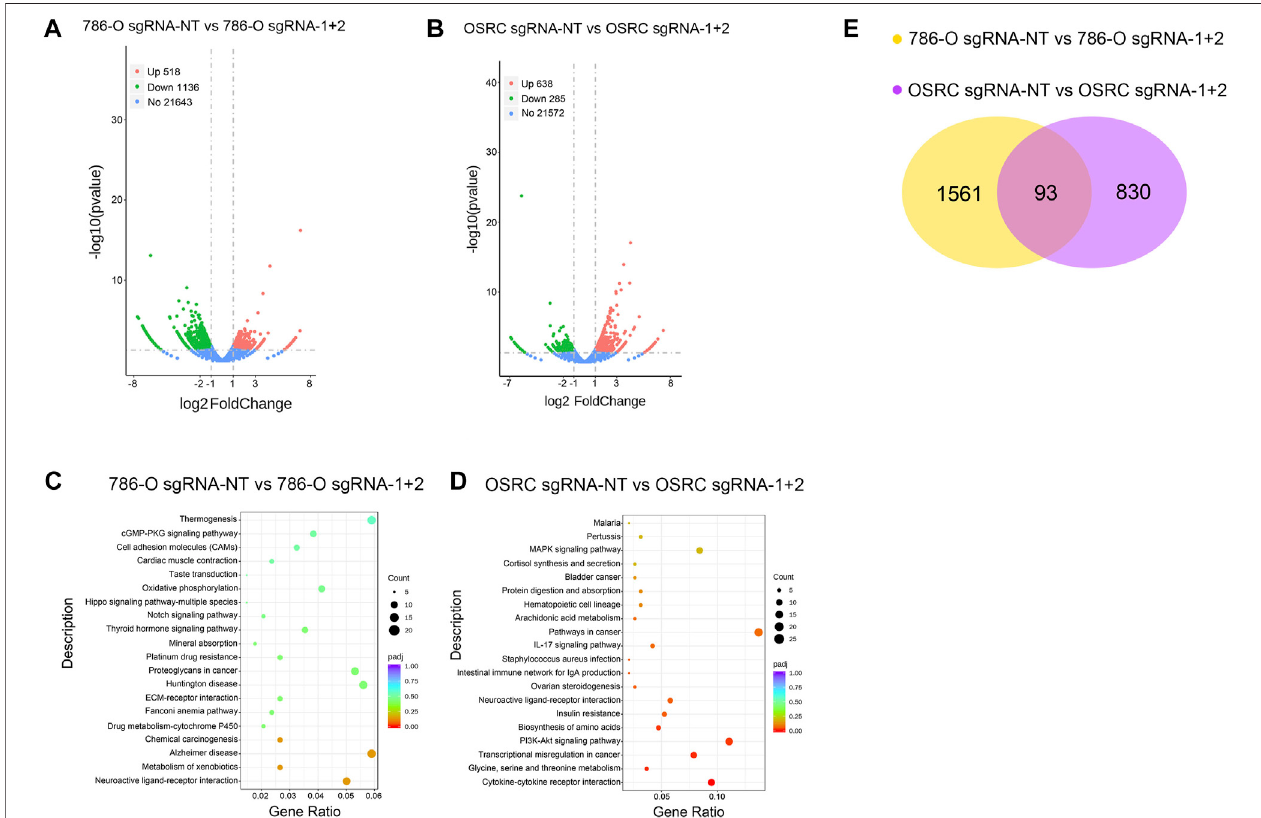
FIGURE 5 | The effect of LncRNA NEAT1 Hypermethylation on the transcriptome (A,B) Differentially expressed genes in 786-O and OSRC cells after transfected with dCas13 b-METTL3 and sgRNAs (C,D) KEGG pathway analysis of differentially expressed genes in 786-O and OSRC cells (E) The Venn diagram summarizes the overlap of differentially expressed genes in both